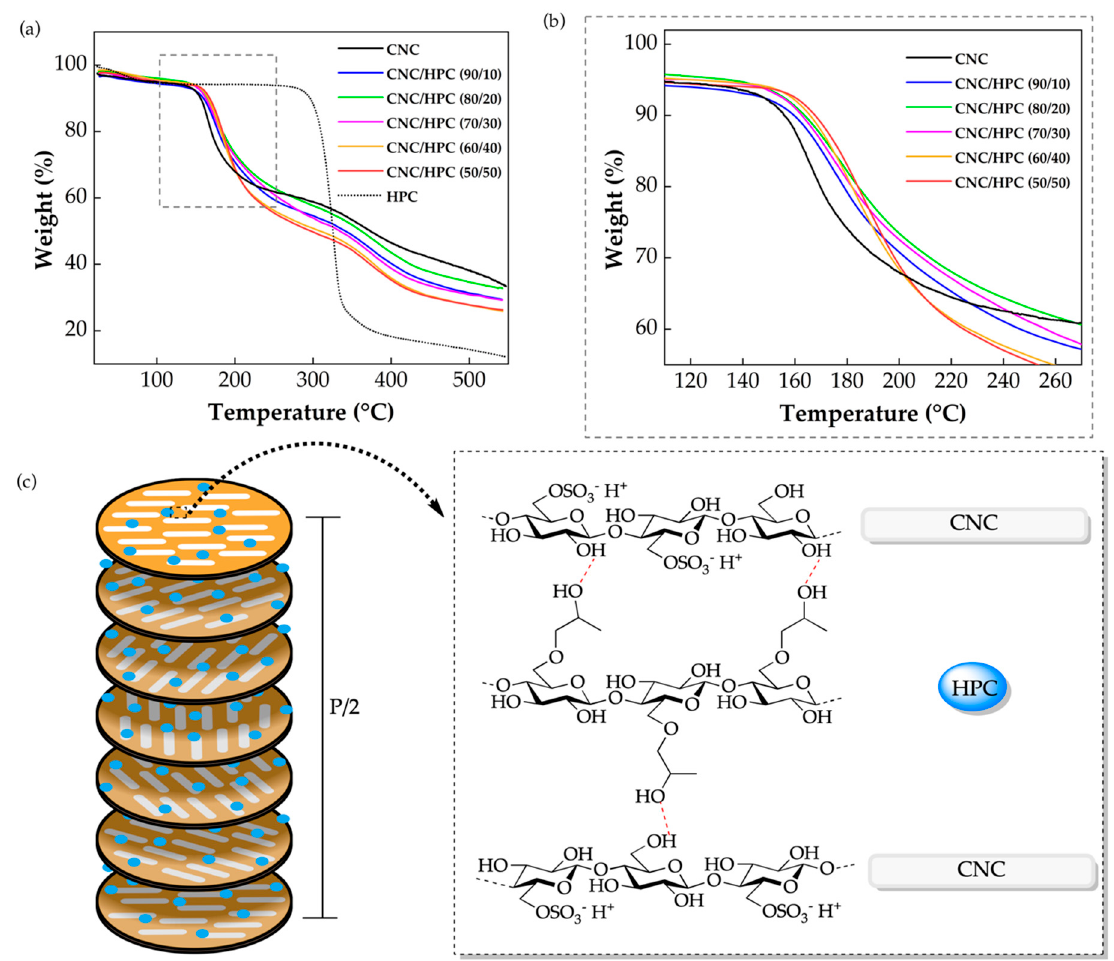
Figure 5. ( a ) Thermogravimetric analysis curves of neat CNCs, HPC and CNCs / HPC composites; ( b ) inset of the thermogravimetric curves in the range of temperatures of 110–260 ° C; ( c ) proposed chiral nematic arrangement (right) where the CNCs rods (white anisotropic particles) are surrounded by HPC macromolecules (blue dots), the left scheme shows some possible hydrogen bonding (red dashed lines) between the OH groups of CNCs and HPC. Note that the representation of the number of substituents on the CNC or HPC schematics is not